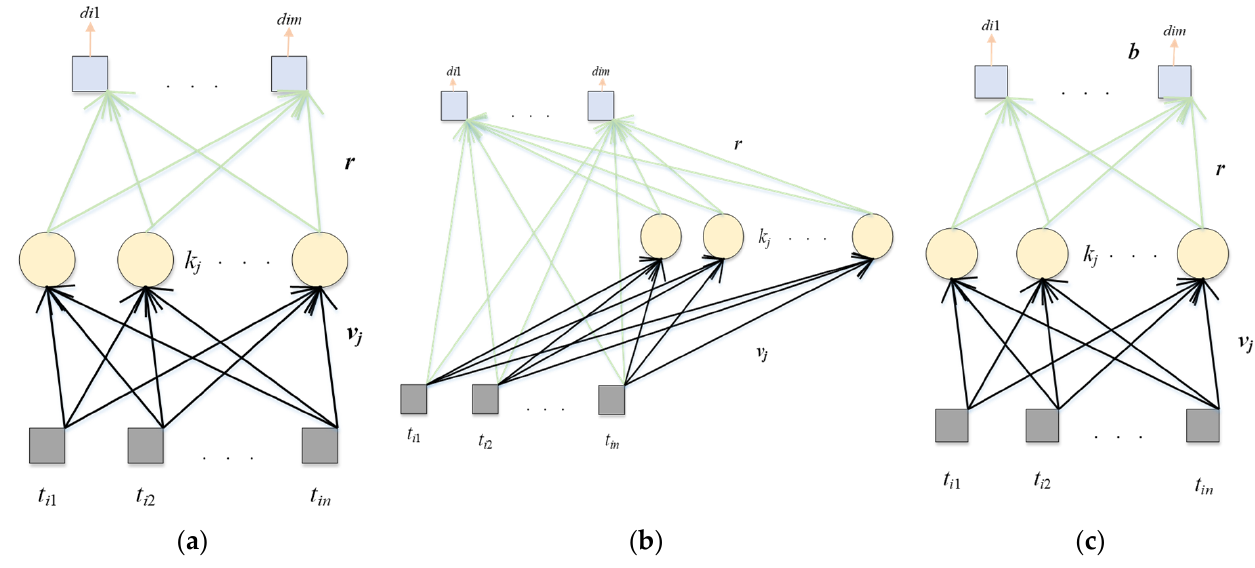
Figure 5. The structures of three RNNs. ( a ) ELM; ( b ) RVFL; ( c ) SNN.